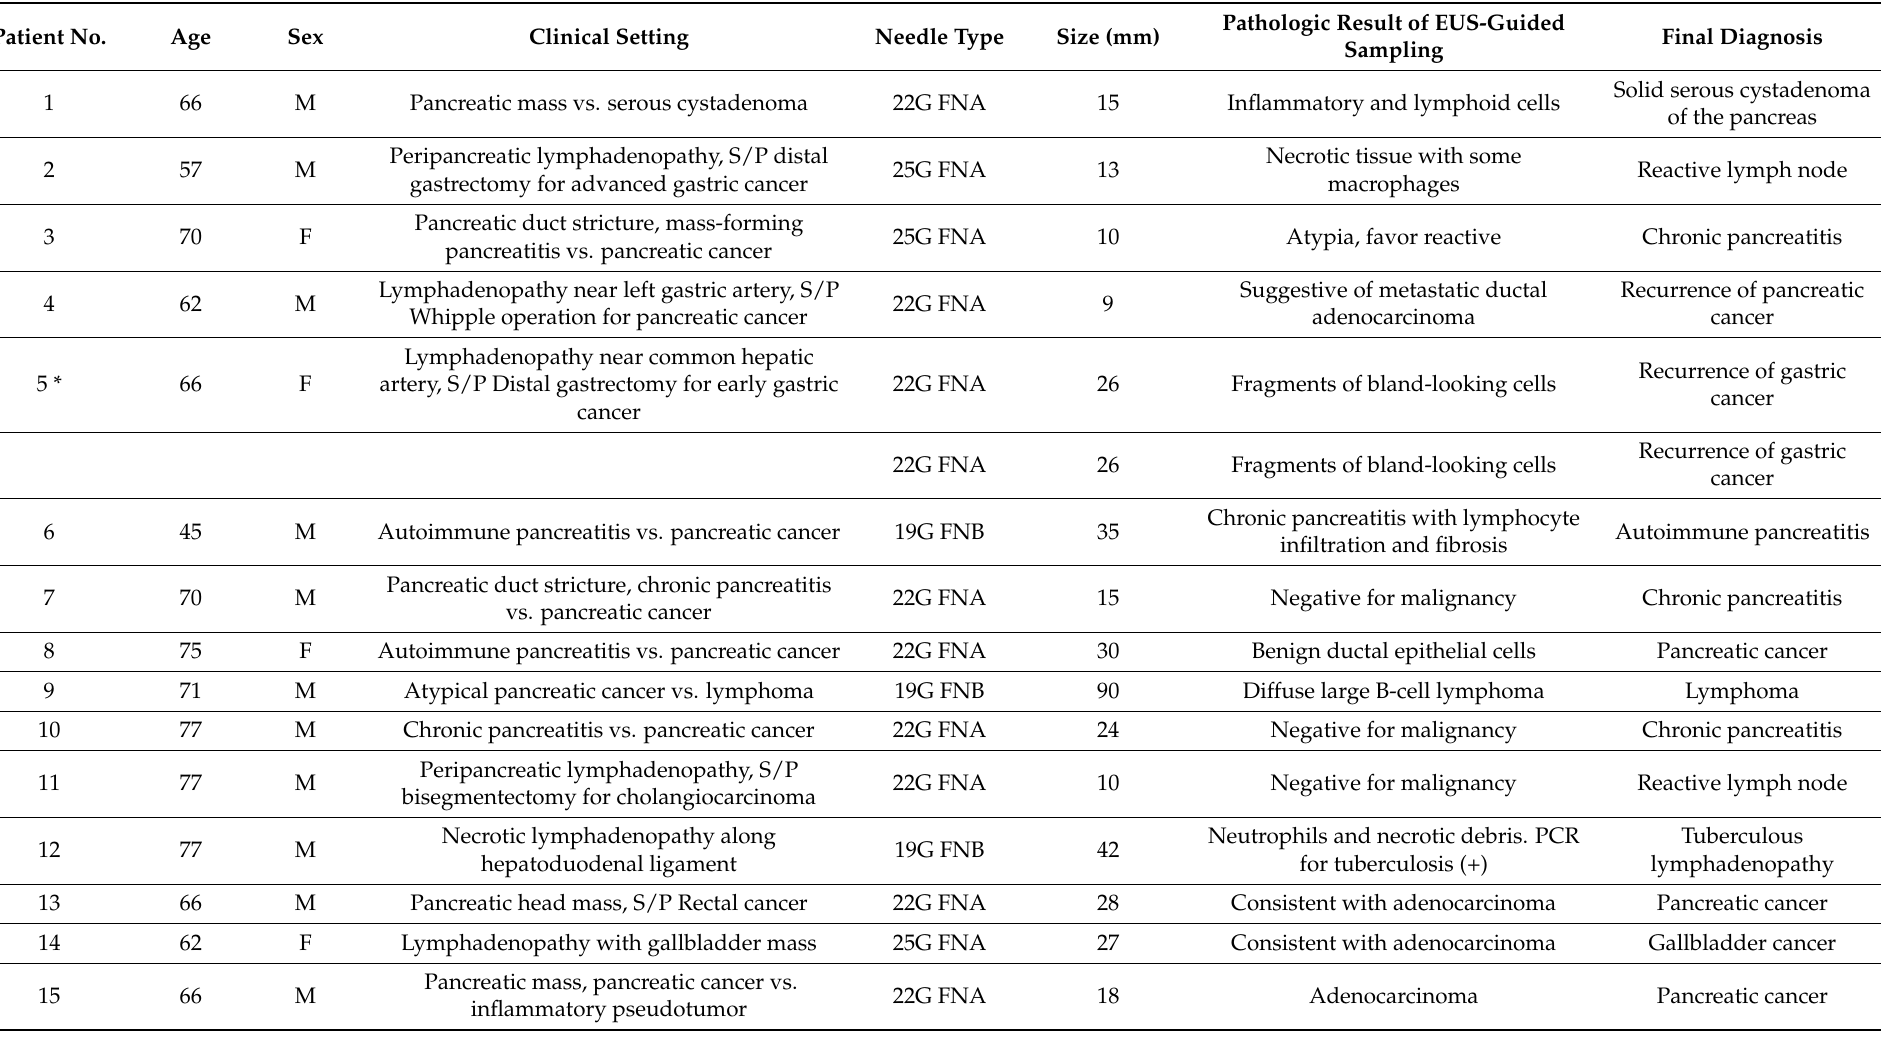
Table 1. Clinical data and final diagnosis of 21 patients who underwent EUS-guided sampling for decision making due to indeterminate radiological diagnosis. Patient No. Age Sex Clinical Setting Needle Type Size (mm)